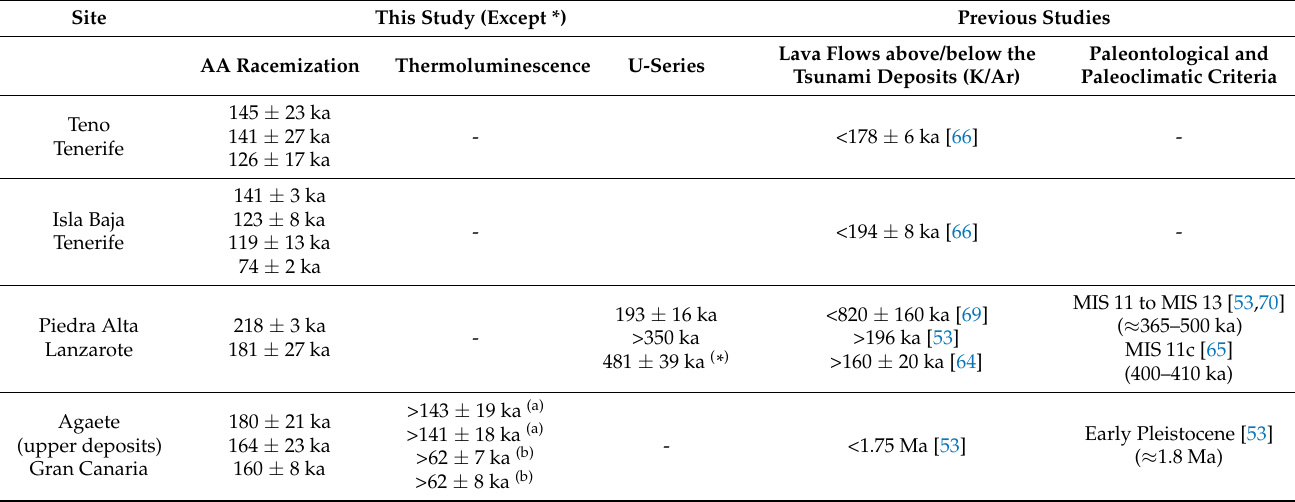
(a,b) Data from two different outcrops. The symbols < and > in the K/Ar ages mean that the dated lava flow underlies or overlies the tsunami deposits, respectively. ( * ) From Ref.